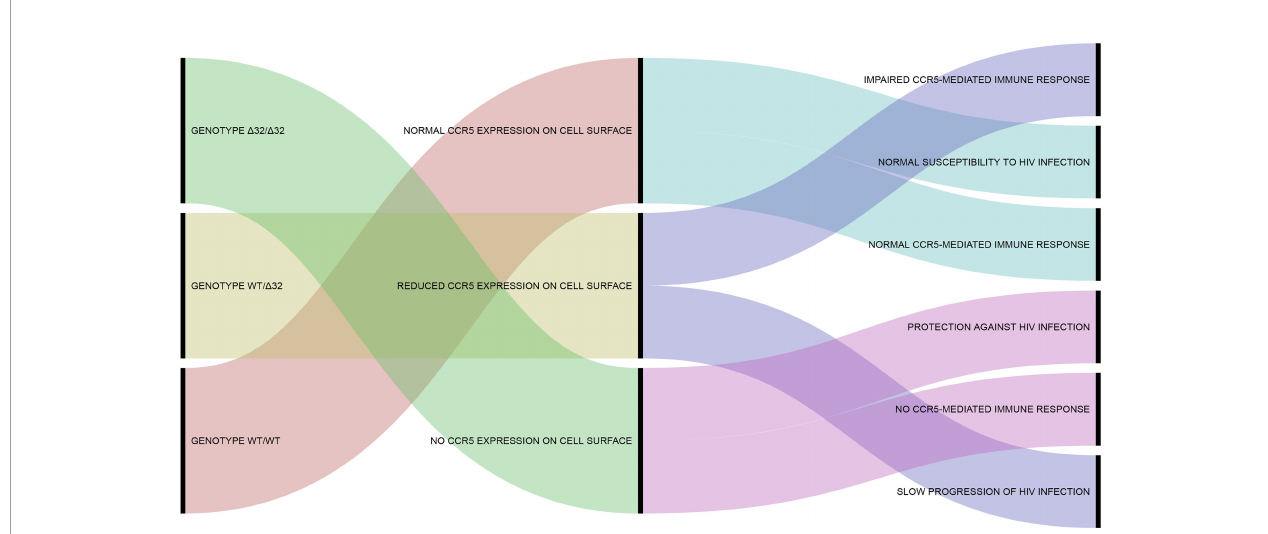
FIGURE 1 | Alluvial diagram representing the classic outcomes associated with the CCR5 D 32. The CCR5 D 32 genotypes are shown in the left part of the diagram. The phenotypic effects of each genotype are shown in the center. The more classical consequences associated with each phenotype are shown in the right part of the diagram. Additional information concerning the phenotypic effects of the CCR5 D 32 on human cells and immune system can be found in previous studies of our group (40, 68, 81). This fi gure was created using RAWGraphs (https://rawgraphs.io/)